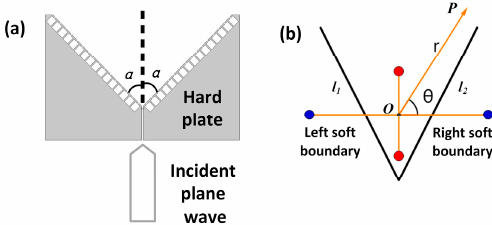
Figure 1. Mechanism for realizing a quadrupolar resonance. ( a ) Schematic of the structure. ( b ) Equivalent schematic of the structure, implying a quadrupolar resonance, the positive sources are red and negative sources are blue.